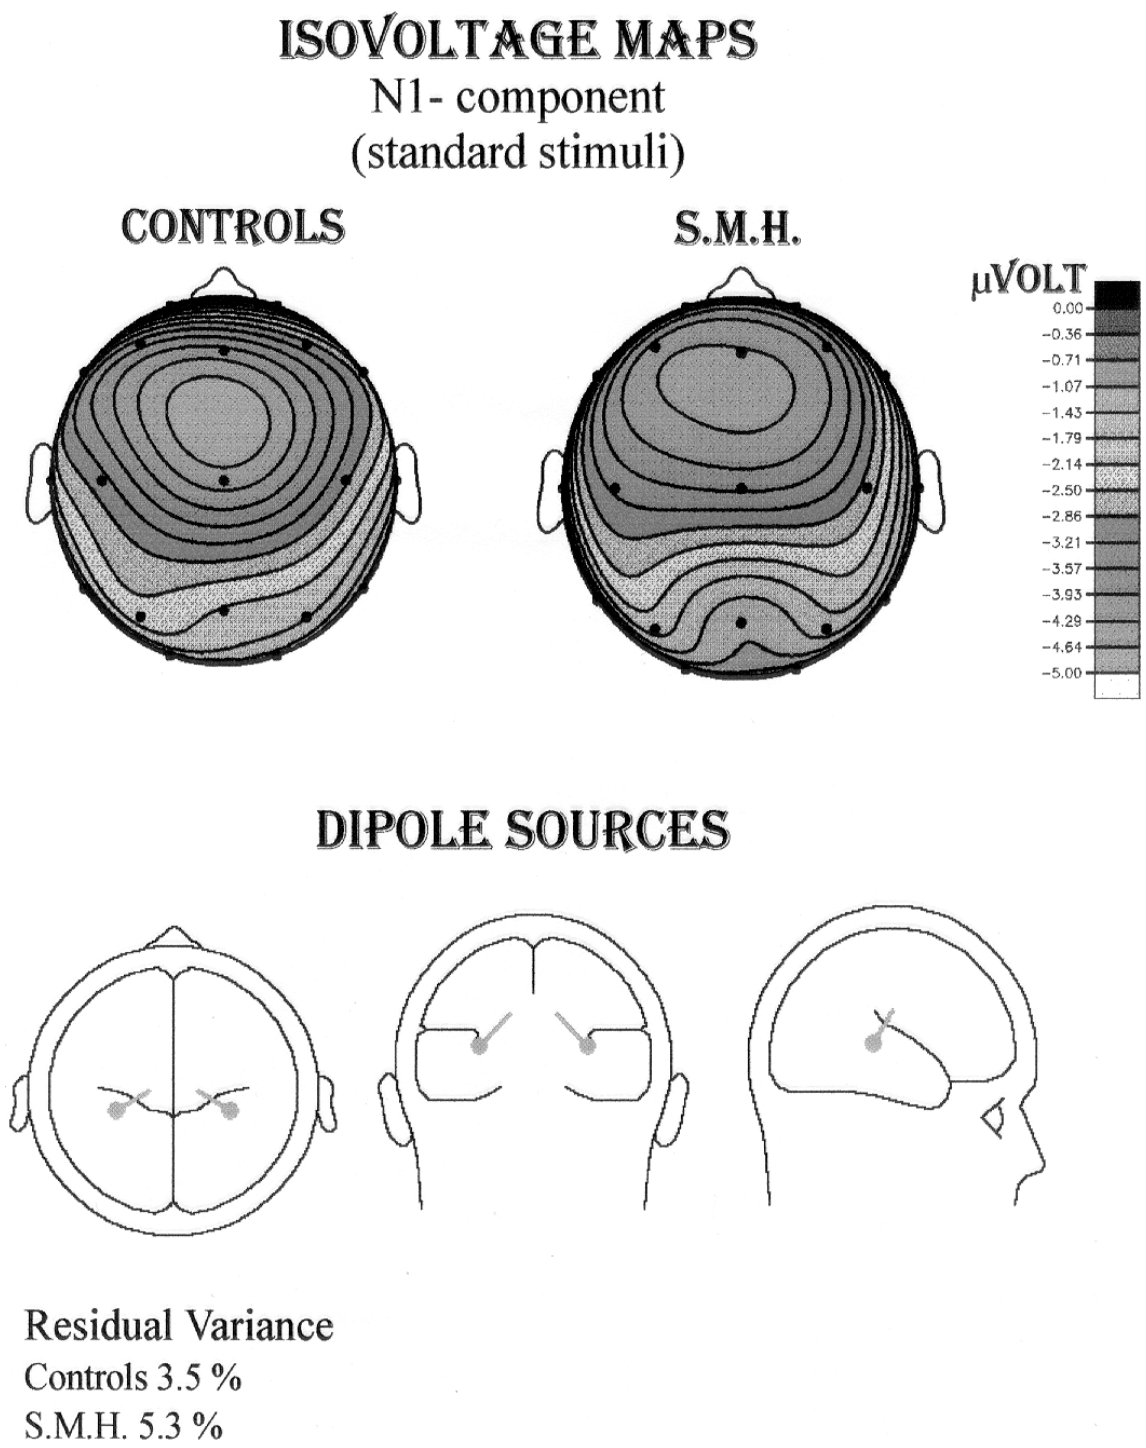
Fig. 4. Top: Isovoltage Maps of the N1 component. The timewindows subtended 50ms and were centered upon the N1 peak latency. Bottom: Brain Electric Source Analysis (BESA) solution of the control subjects’ N1 component (residual variance 3.5%). Using this solution upon S.M.H.’s N1 component the residual variance is